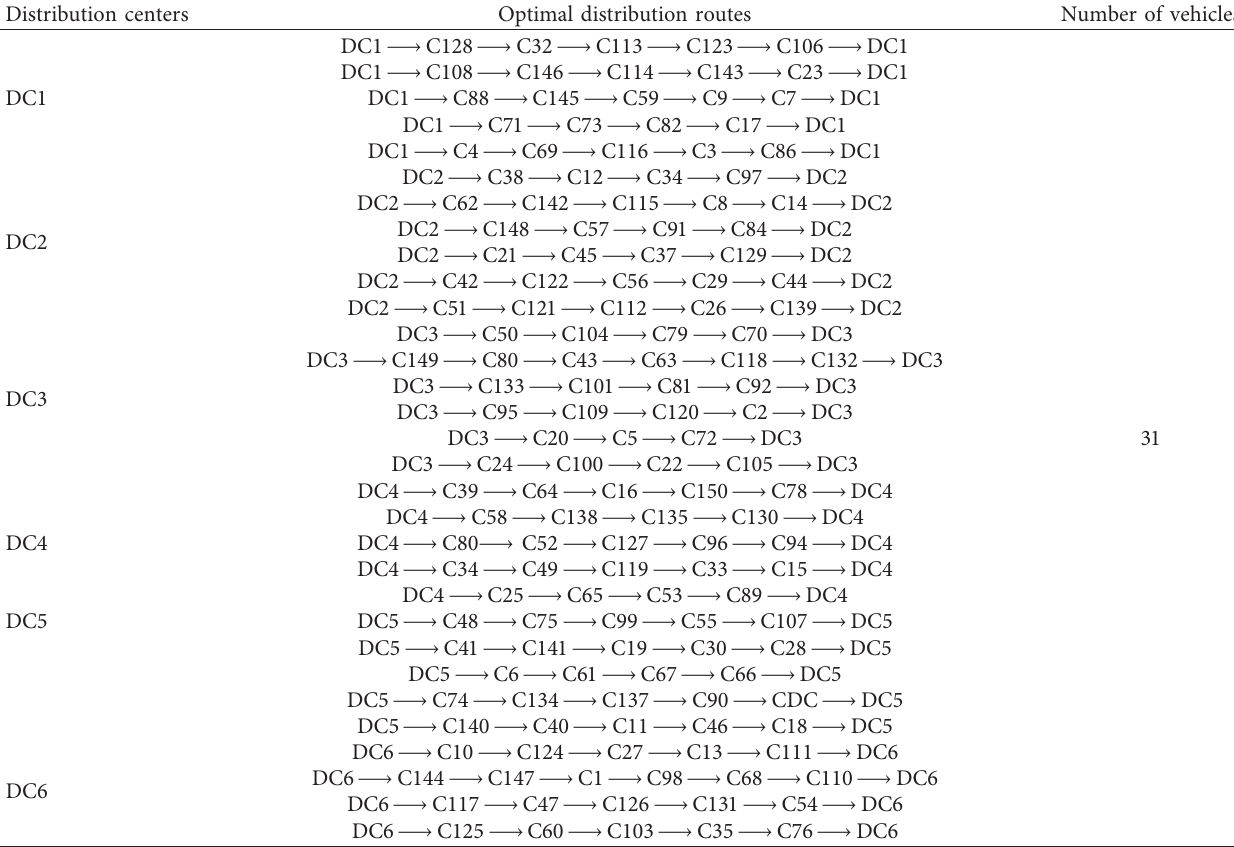
Table 4: Initial distribution routes of logistics network.